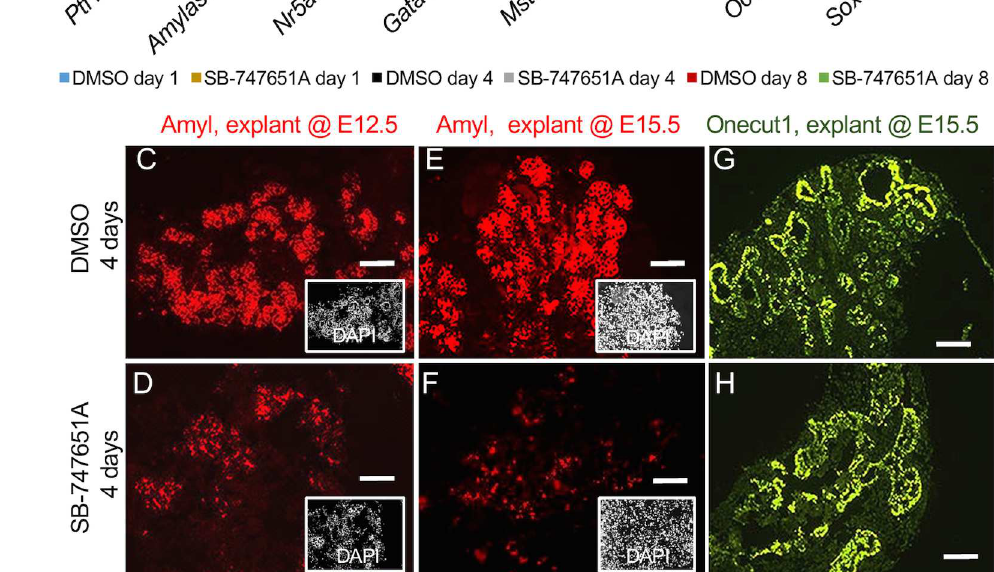
Fig 7. Acinar fates are markedlydepleted upon SB-747651A treatment. (A) Expressionlevels of indicated acinar and duct genesupon culture of E12.5 explantsfor 1 and 4 days. Y-axis shows relativefold changein DMSO controls and uponSB-747651Atreatment. P-values (cid:20) 0.01 for both Ptf1a and Amyl for day 4, n = 3 biologicaland 3 technicalreplicates.(B) Expressionlevelsof indicatedacinar and duct genesuponcultureof E15.5explantsfor 1 day, 4 days, and 8 days on explantstreated with DMSO or SB-747651A(n = 3 independent replicates). Y-axis shows relativefold changein DMSO controlsand uponSB-747651Atreatment. Colorschemefor the bar graphsis displayed in the figure. n (cid:21) 10pancreatafor eacheach biologicalreplicatefor DMSO and SB-747651Atreatment, P-values (cid:20) 0.01 for Ptf1a and Amyl for day 4 and day8, n = 3 biologicaland 3 technicalreplicates.(C-F) Immunohistochemistry showingAmyl expression on pancreaticsectionsfrom E12.5(C, D, scale bar = 50 μ m)and E15.5(E, F, scale bar = 50 μ m)stages harvested at 4 days of culture. n (cid:21) 5pancreata for each biologicalreplicate for DMSO and SB- 747651Atreatment n = 2 biologicalreplicates. (G, H) Oc1 expressionin sectionsfrom pancreaticexplantsfrom E15.5 stage (scalebar = 100 μ m,G, H) from DMSO or SB-747651Atreated explants, harvestedat 4 days of culture. Insets shows pseudo-coloredDAPI staining.Valuesare averagesof independent experiments ± standard error